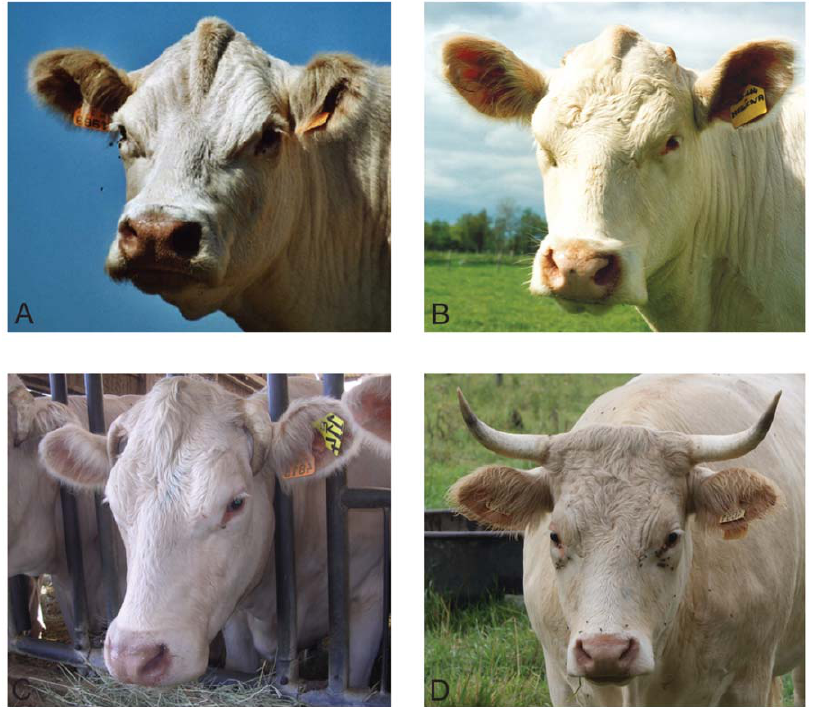
Figure 1. Phenotypic description of type 2 scurs syndrome. Ten-(A), two-(B) and four-(C) year old females affected by type 2 scurs syndrome. Note the marked phenotypic variability and the negative correlation between the size of scurs and the importance of acrocephaly and ridge-shaped extra bone deposition along the interfrontal suture. (D). Four-year old horned female.